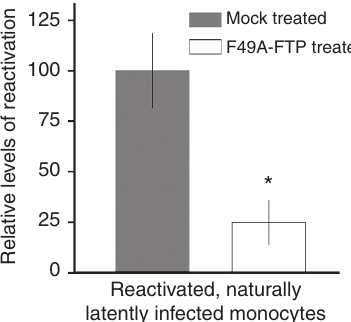
Figure 6 | F49A-FTP kills naturally latently infected monocytes, reducing reactivation events. 1.2 (cid:2) 10 8 blood monocytes were isolated from CMV- positive blood donors. Half of these cells were incubated with F49A-FTP for 72h. Monocytes were then differentiated using granulocyte-macrophage colony-stimulating factor (GM-CSF) and interleukin-4 (IL-4) stimulation followed by LPS treatment. Monocyte-derived, mature dendritic cells (reacti- vated latent monocytes) were then co-cultured with fibroblasts for 3 weeks, and the numbers of reactivated IE foci were detected by immunofluorescent staining. Means and error bars (showing s.d.) were generated from three independent experiments. Statistical analyses were carried out using a paired two-tailed t -test and P values expressed as * P ¼